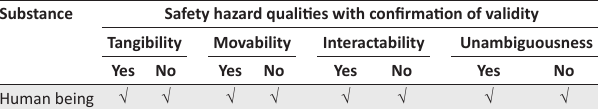
TABLE 2: The human being as a safety hazard. Substance Safety hazard qualities with confirmation of validity